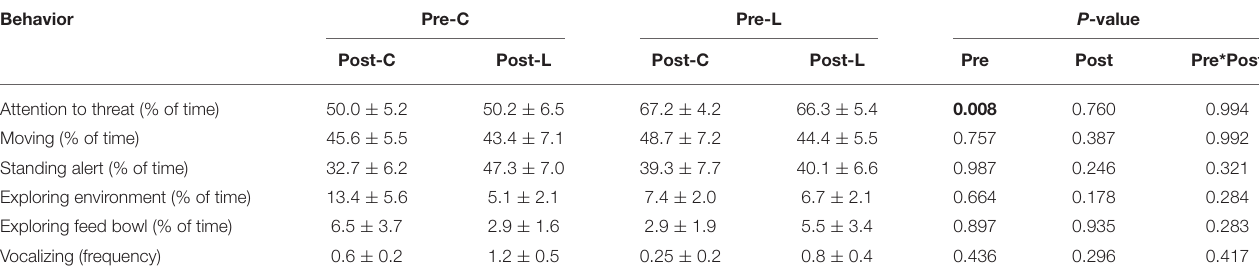
TABLE 9 | Behavior performed in the attention bias test during the 10s threat. Behavior Pre-C Pre-L P -value Post-C Post-L Post-C Post-L Pre Post Pre*Post Attention to threat (% of